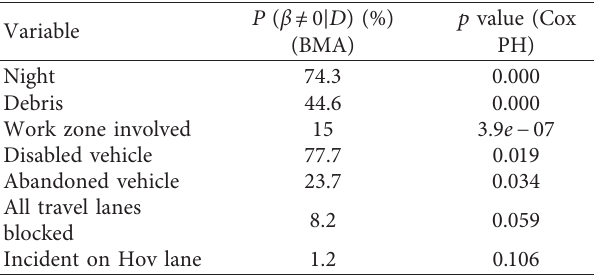
Table 6: Performance index values for the Cox PH, log-logistic AFT model and BMA models.